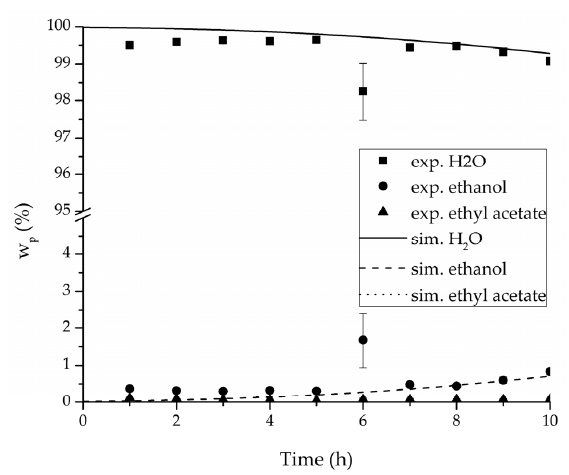
Figure 14. Experimental and simulation feed mass fraction for the ternary system at 95 °C feed temperature.